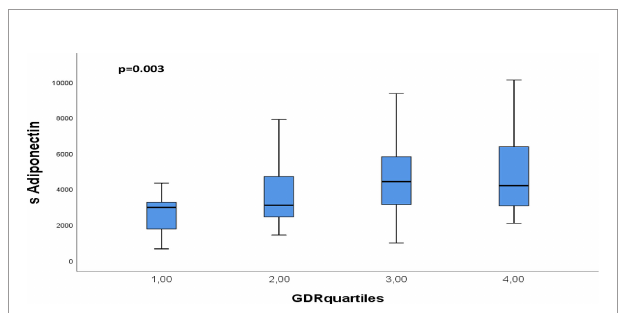
FIGURE 3 | Distribution of circulating adiponectin through quartiles of GDR. p-values refers to Kruskall Wallis test.